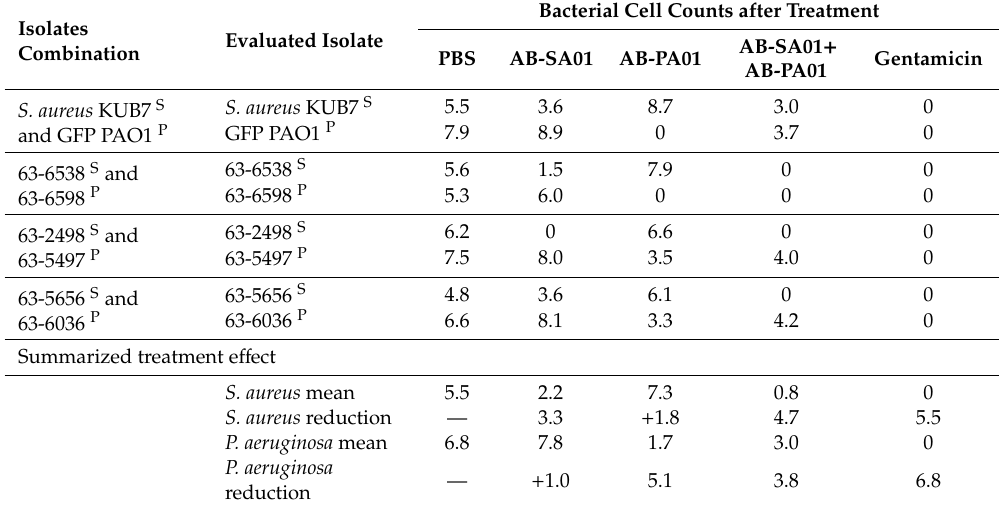
Table 1. Bacteria cell count (log 10 (CFU / mL)) of S. aureus and P. aeruginosa in mixed-species planktonic culture after 24 h phage cocktails, gentamicin, or PBS